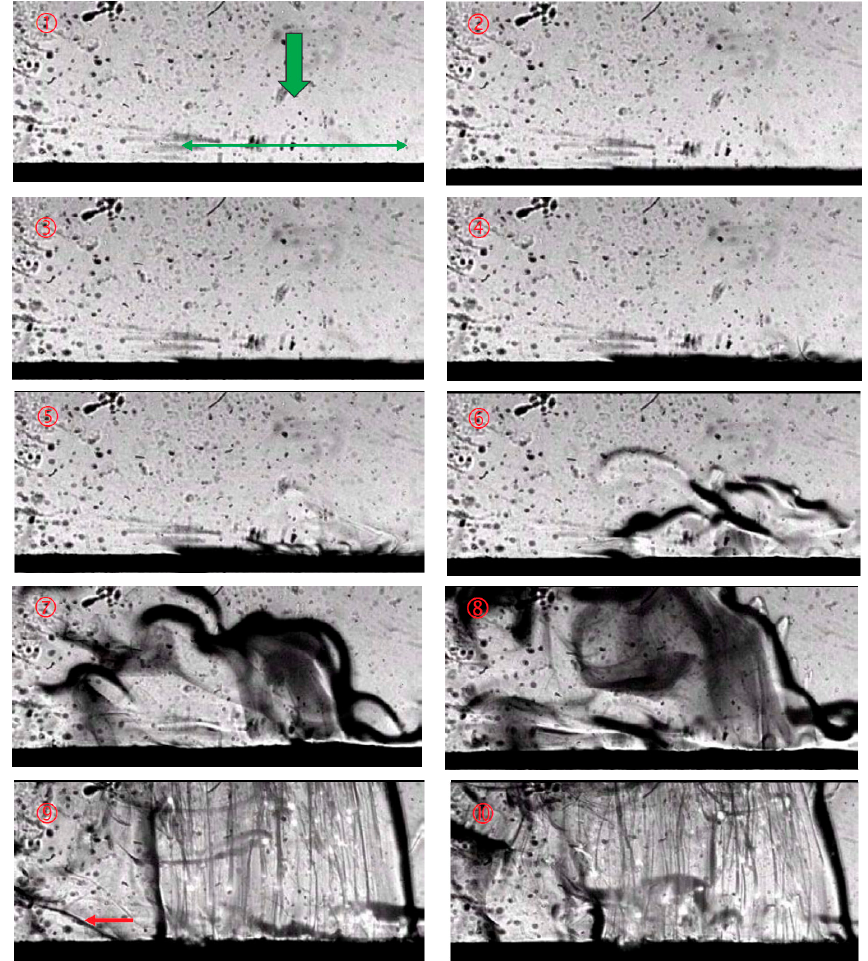
Figure 22. HTPB/AP/Al propellant ignition phase and fame propagation by shadowgraph, represented in subfigures from 1 to 10 with a time interval of 1 ms, where (1) is the ignition instant (with a CO 2 laser). Reprinted with permission from Ref. [42] (2022).